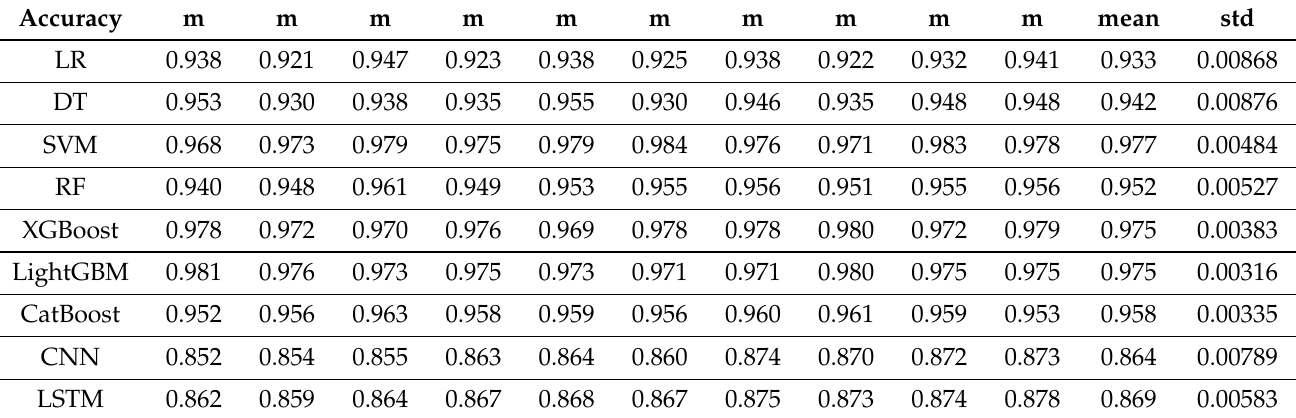
Table 11. Validation accuracy of ten-fold cross-validation on